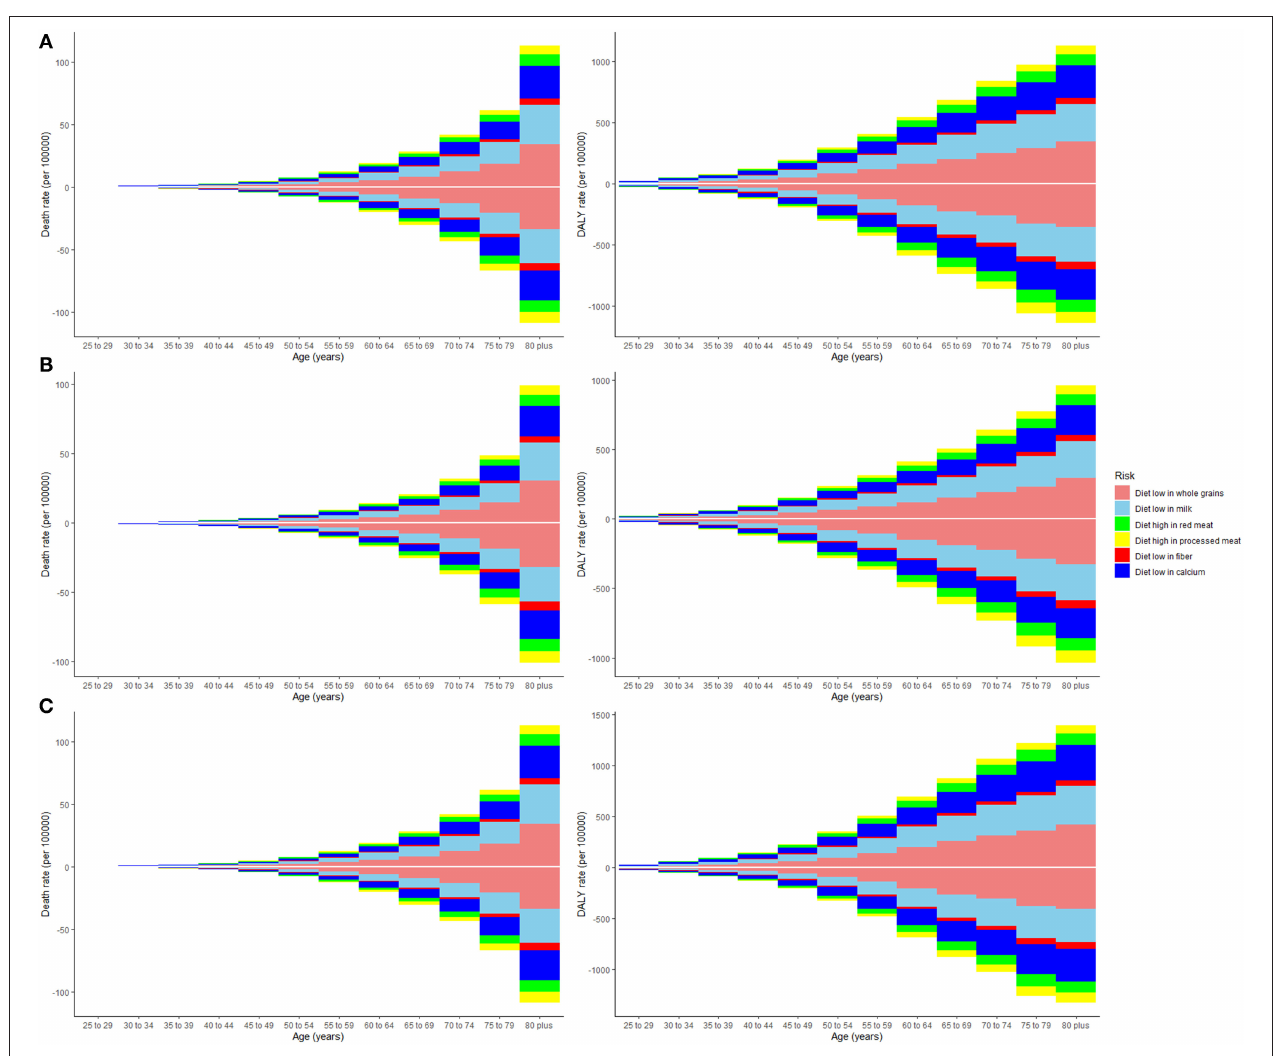
FIGURE 2 | The death and disability-adjusted life-years (DALY) rate of six dietary risk factors related to colorectal cancer among various age groups. The upper column in each group represents data in 2019, and the lower column in each group represents data in 1990. The vertical axis is the death or DALY rate (per 100,000 persons). The horizontal axis represents different age groups. (A) Both genders, (B) women, and (C)